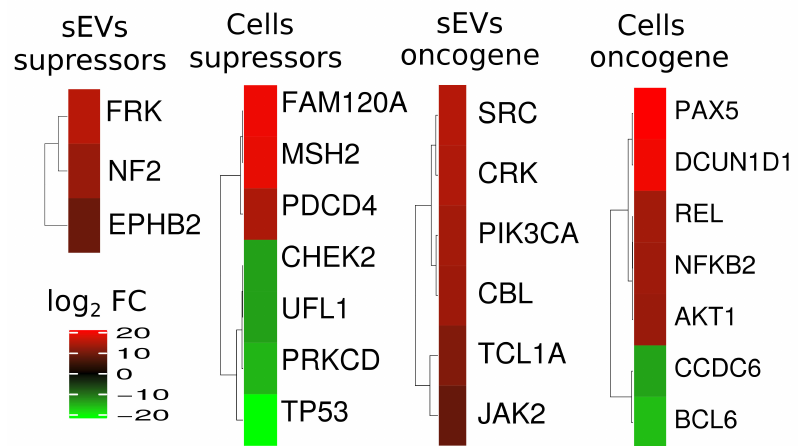
Figure A6. Tumor suppressors and oncogenes overlapping with significantly regulated proteins (adjusted p value < 0.05) from cells and EVs. Red indicates upregulated in ABC and green downregulated in ABC compared GCB.